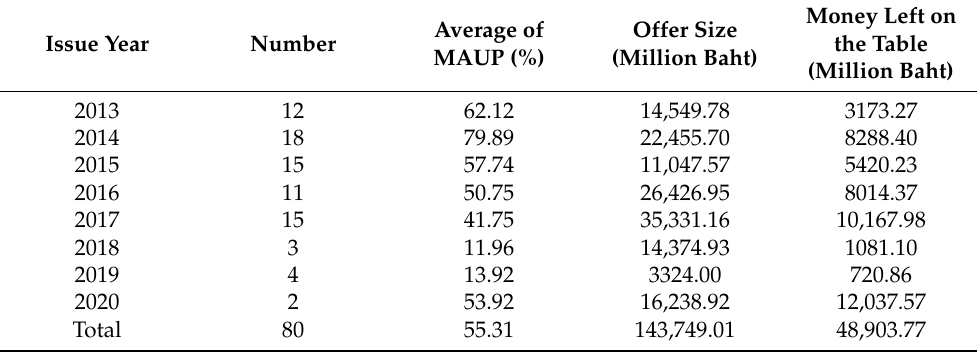
Table 4. Distribution of newly listed companies, underpricing, offer size, and money left on the table from 2013 to